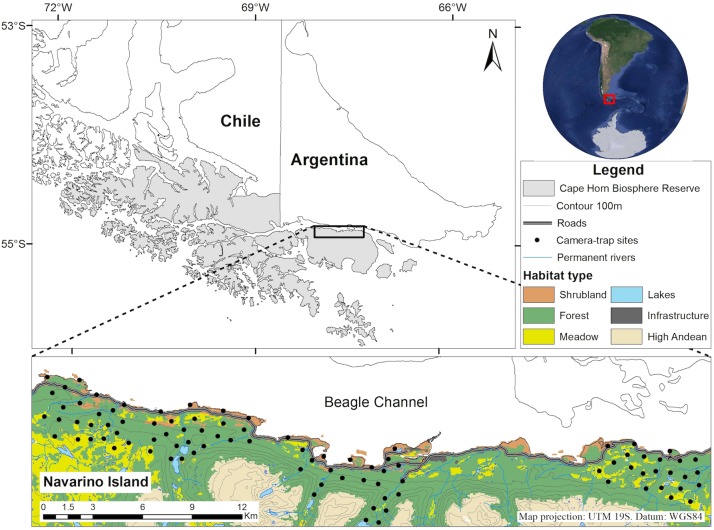
Study area location and study design.Location of 93 camera-trap stations used to study occupancy and temporal activity of the American mink on the northern slope of Navarino Island, within the Cape Horn Biosphere Reserve, southern Chile.